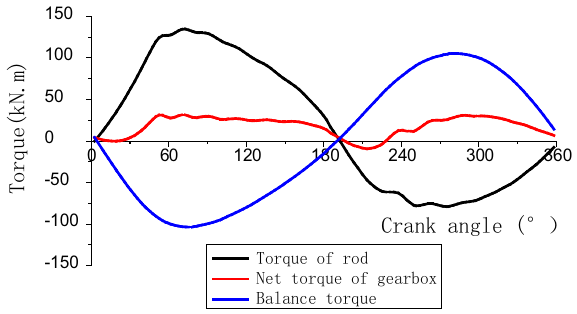
Fig. 7 Torque curve of the lower barbell pumping units